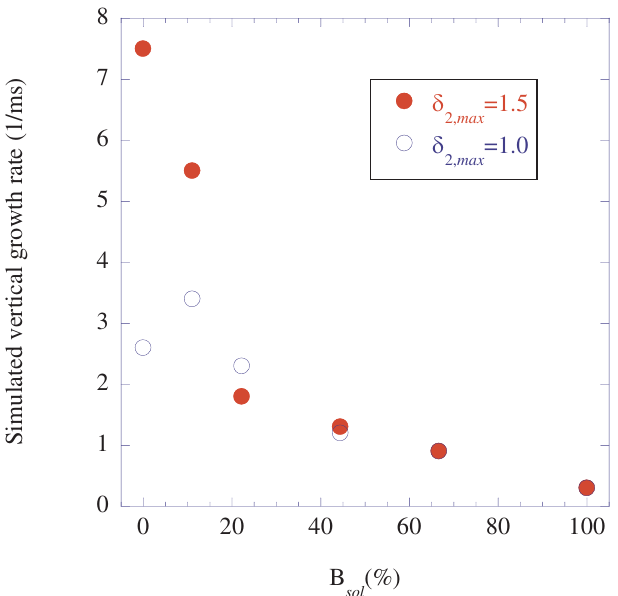
FIG. 17. (Color) Simulated vertical growth rate for the case of (cid:1) 1 : 5 (solid circle) and (cid:1) (cid:1) 2 ; max (cid:1) is the secondary yield of the 2 ; max